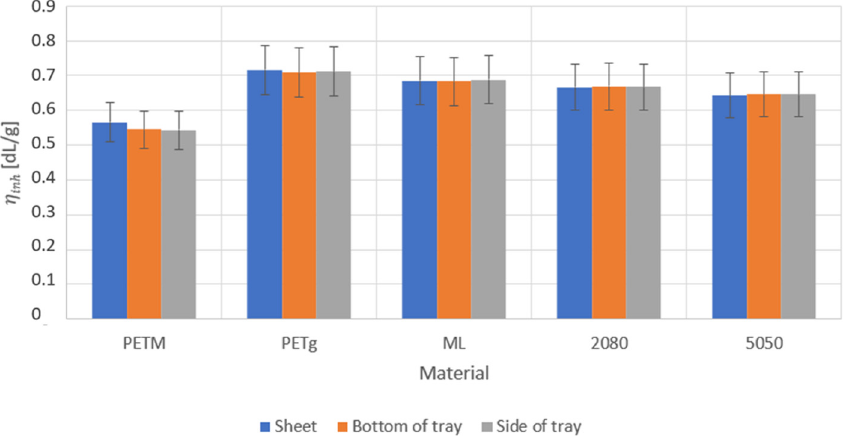
Figure 8. Inherent viscosity of the sheets and multilayer sheets before (blue) and after thermoforming for the samples taken in the bottom (orange) and at the wall (gray) of the thermoformed tray. All the samples are listed in Table 2.